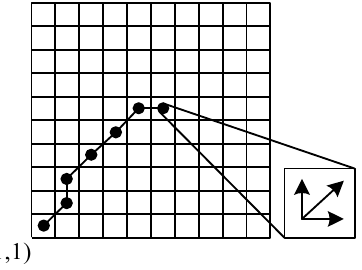
Figure 4. Principle of DTW algorithm.